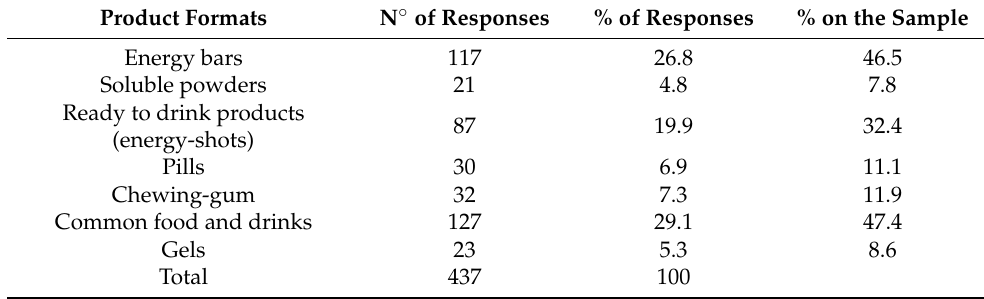
Table 10. Perception of caffeine-containing products’ formats for sports performance